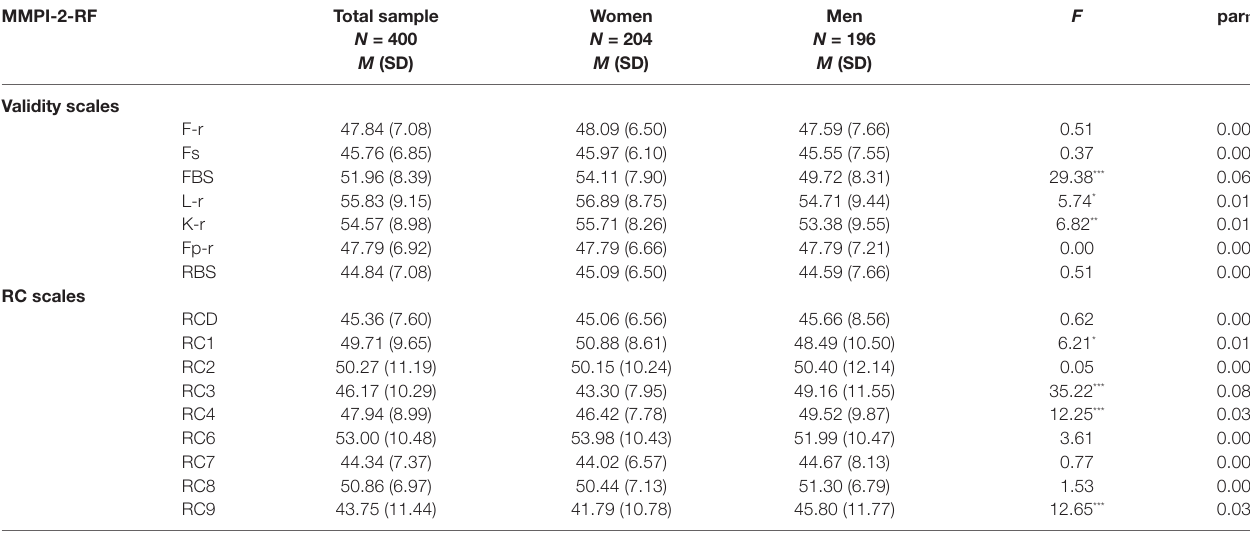
TABLE 3 | Mean T-scores and standard deviations for women and men for the MMPI-2-RF validity and RC scales with associated univariate F values and effect sizes.